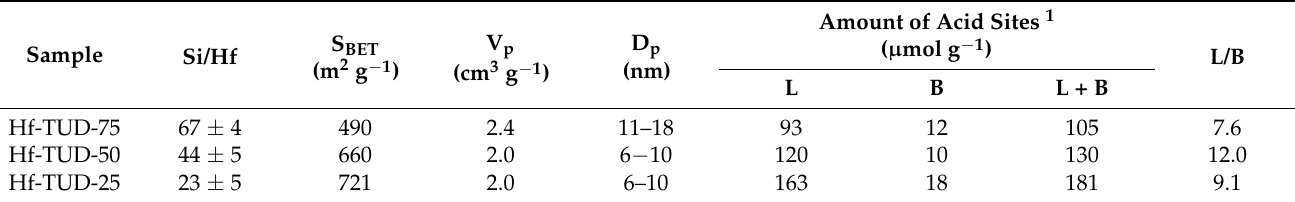
Table 1. Composition, textural, and acid properties of the Hf-TUD-1(x) materials.